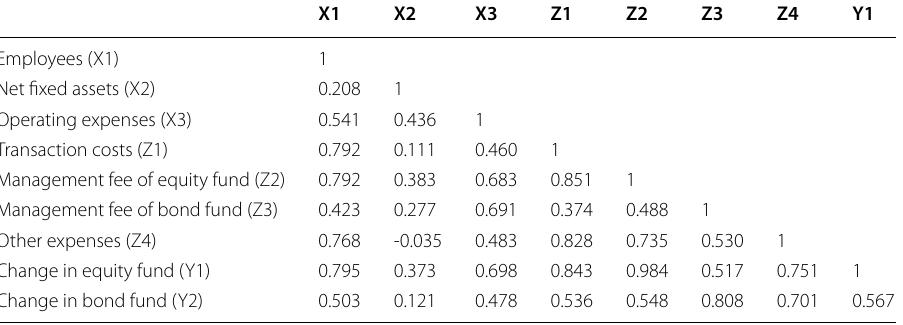
Table 4 Correlation matrix